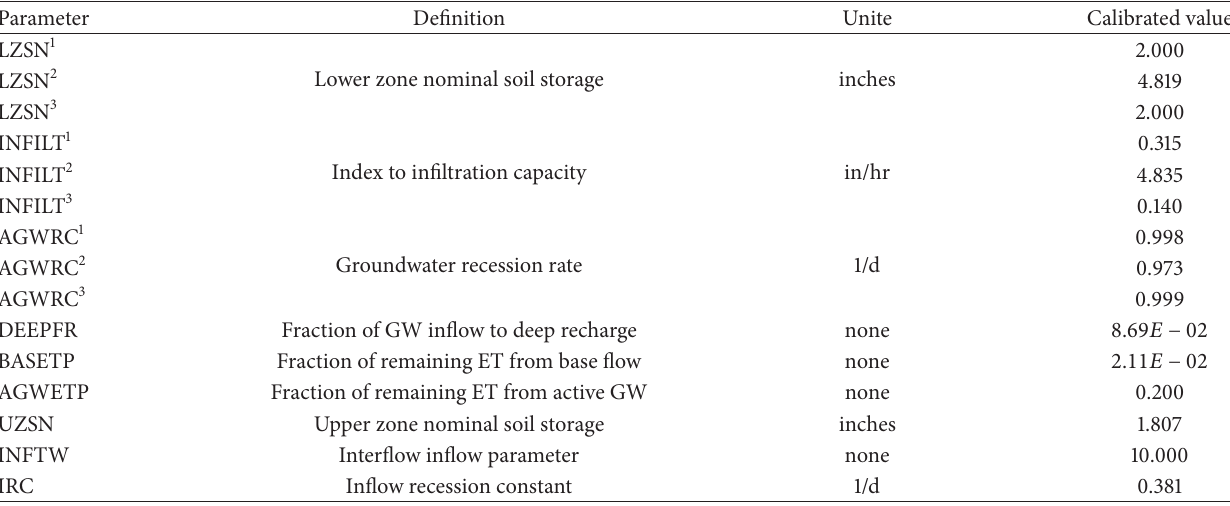
Table 2: List of adjusted parameters for calibration of HSPF model.